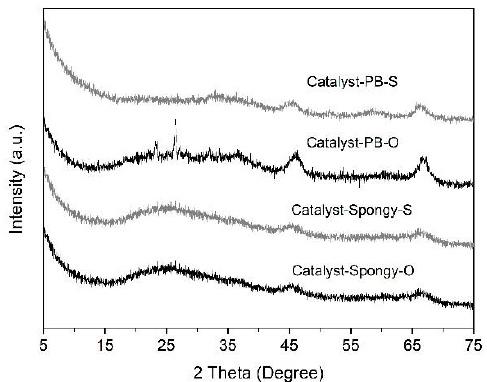
( c ) Figure 4. ( a ) NH 3 -TPD profiles obtained from Al 2 O 3 -Spongy and Al 2 O 3 -PB, and ( b , c ) DRIFT spectra of pyridine adsorption on the obtained alumina samples. 3.2. Characterization of CoMo/Al 2 O 3 Catalysts After the loading of Co and Mo on Al 2 O 3 -Spongy and Al 2 O 3 -PB, powder XRD patterns for oxidation state CoMo/Al 2 O 3 supported catalyst (denoted as Catalyst-Spongy-O and Catalyst-PB-O accordingly) were recorded to confirm the phase and dispersion of active metal sites on different alumina support. The XRD patterns of oxidation state catalysts are shown in Figure 5. For Catalyst-PB-O, in addition to the characteristic diffraction peaks of γ-Al 2 O 3 , reflections at 22.2° and 23.3° arise from the phase of Al 2 (MoO 4 ) 3 (JCPDS 00-020-0034), while the diffraction peaks at 26.5° and 32.1° are attributed to the phase of CoMoO4 (JCPDS 00-021-0868). This result suggests that except for the formation of CoMoO 4 , some of the deposited MoO 3 interacted with Al 2 O 3 -PB and transformed into Al 2 (MoO 4 ) 3 on the surface of support during the calcination, implying a strong